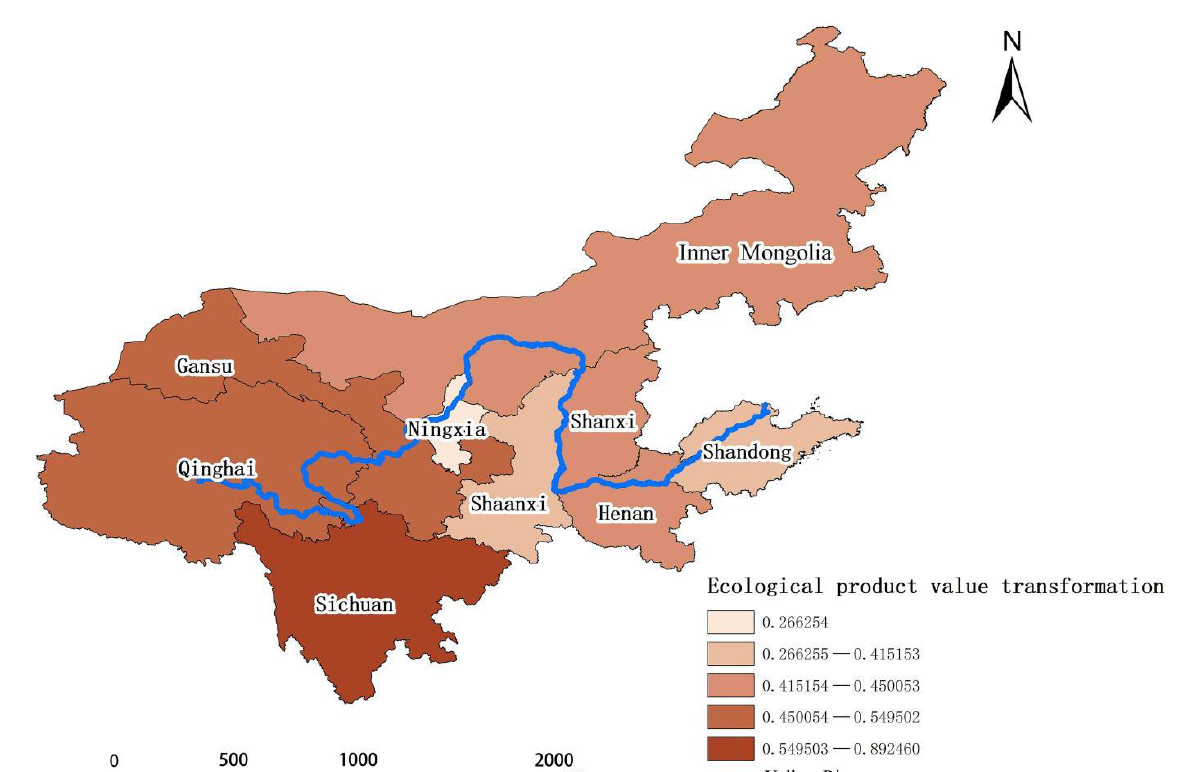
Figure 6. The EPV transformation